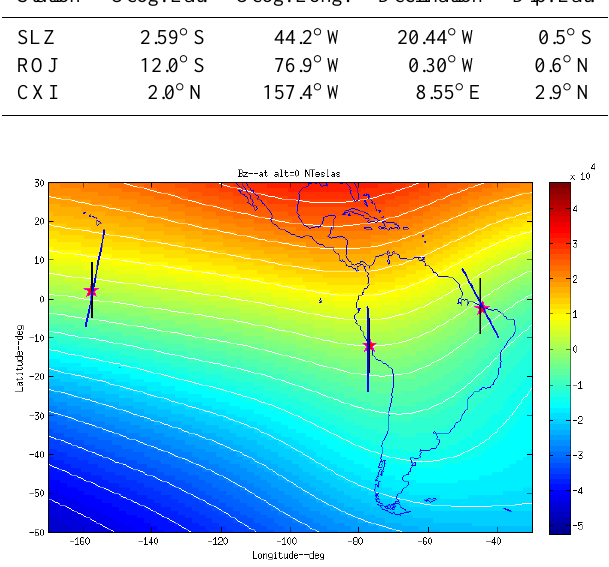
Fig. 1. The geographic position of the three equatorial stations are plotted in stars over the geomagnetic field lines (Bz). The field lines are plotted as Lat-Long-Bz. Modified code of magnetic field lines from Copyright © 2010, Charles